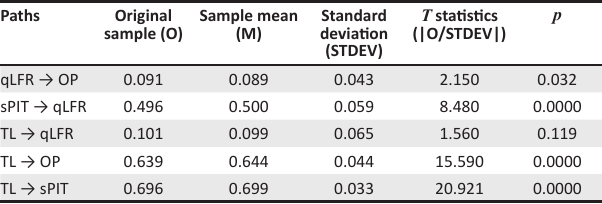
TABLE 3: Path coefficients of inner model. Paths Original Sample mean sample (O) (M)